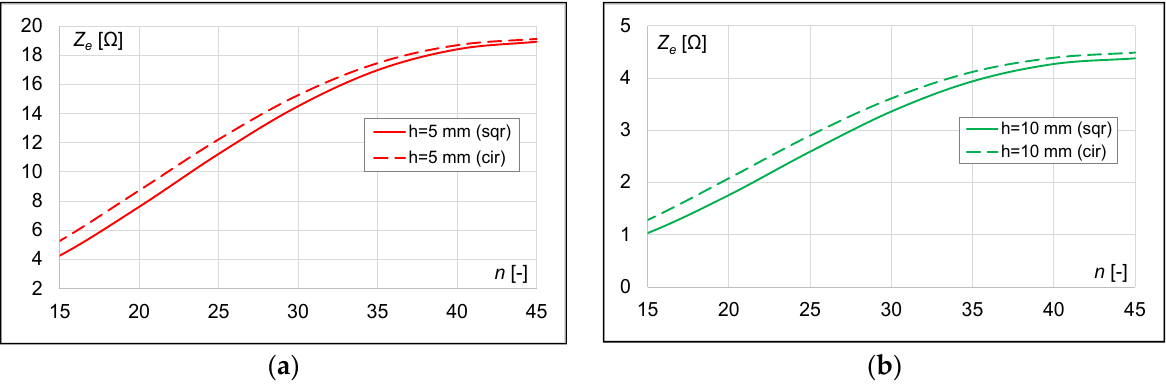
Figure 6. Load impedance at f max for obtaining a maximum efficiency for coil with r = 10 mm at the following distances: ( a ) h = 0.5 r ; ( b ) h = r .